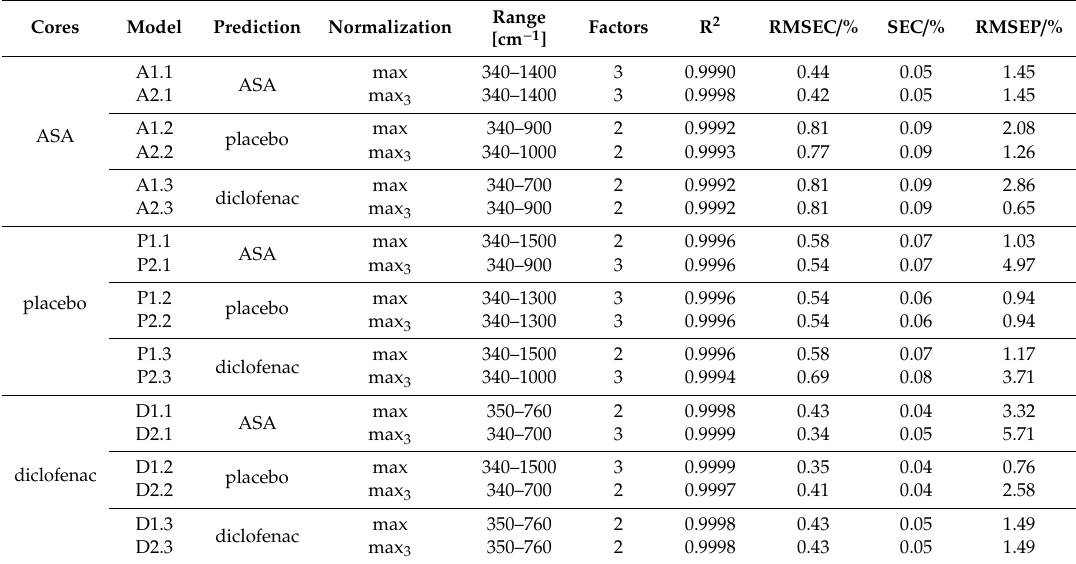
Table 3. PLS-regression (PLSR) calibration and prediction model performance parameters of the TiO 2 -containing coating for ASA, placebo and diclofenac